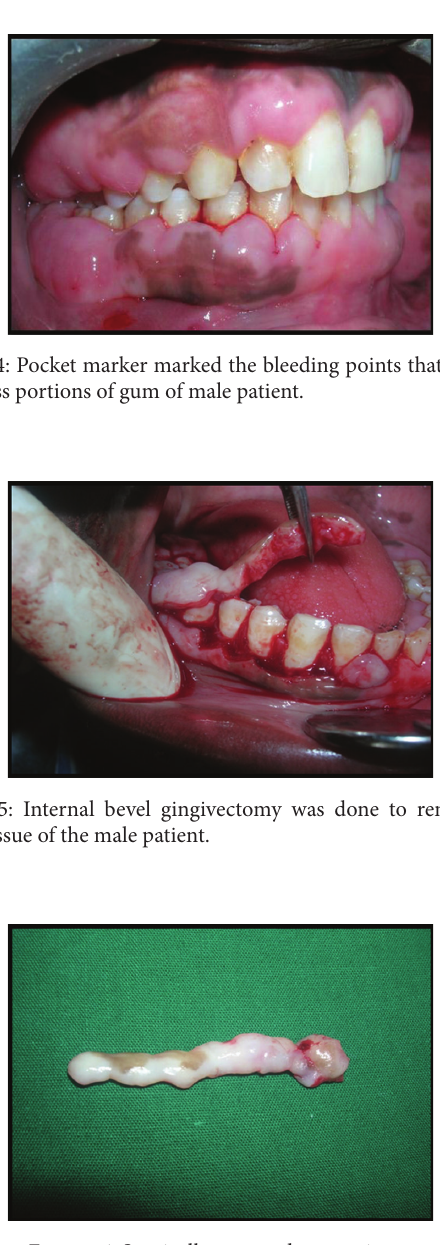
Figure 6: Surgically removed excess tissue.